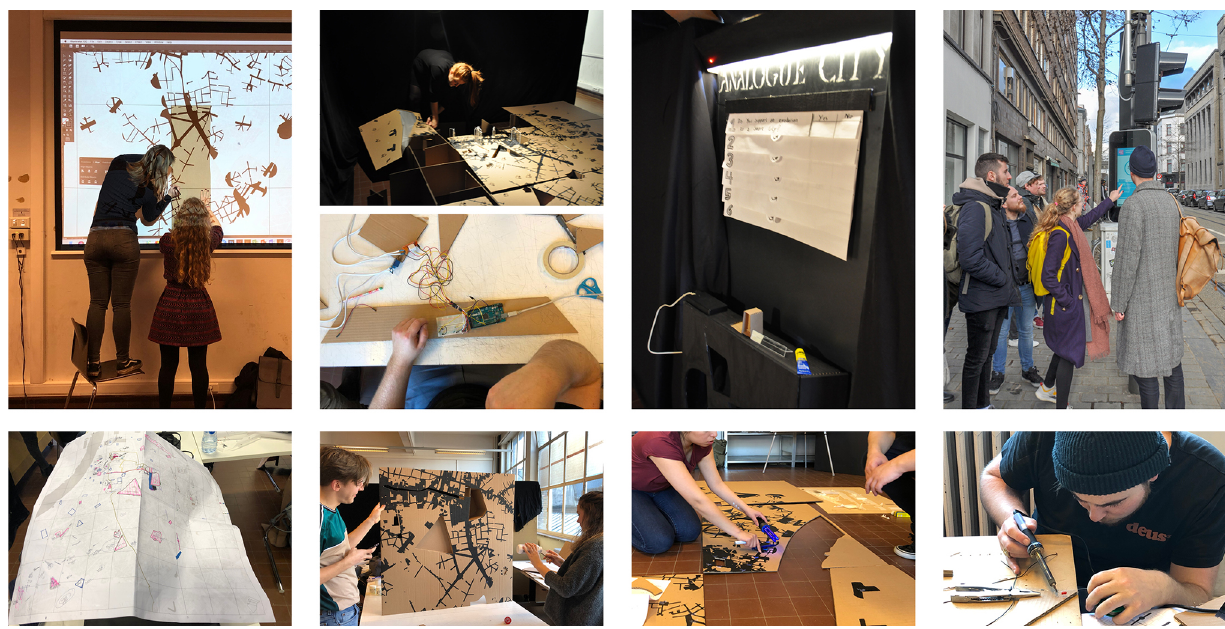
Figure 8. Process of dialogue, interdisciplinary collaborations, and creative production as an integral part of the performa- tive cartography in the ‘Analogue City’ workshop at the University of Antwerp. Sources: The ‘Analogue City,’ IDW University of Antwerp 2019 students, and the